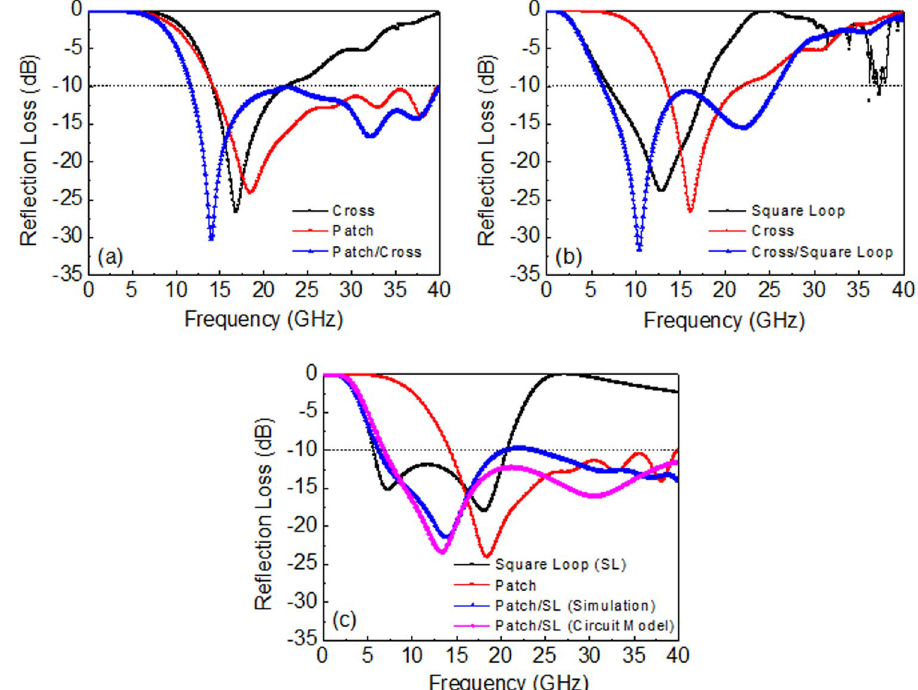
Figure 6. Simulation and calculated results of the reflection loss for the double layered absorbers with different FSS1/FSS2 combinations of optimum design parameters presented in Table 3: ( a ) patch/cross, ( b ) cross/square loop, and ( c ) patch/square